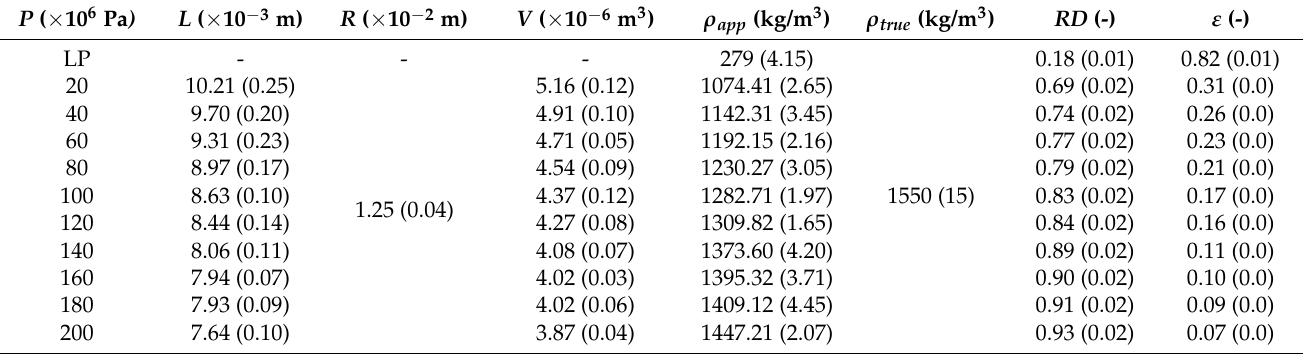
Table 1. Relative density for compressed powder tablets obtained at each compression